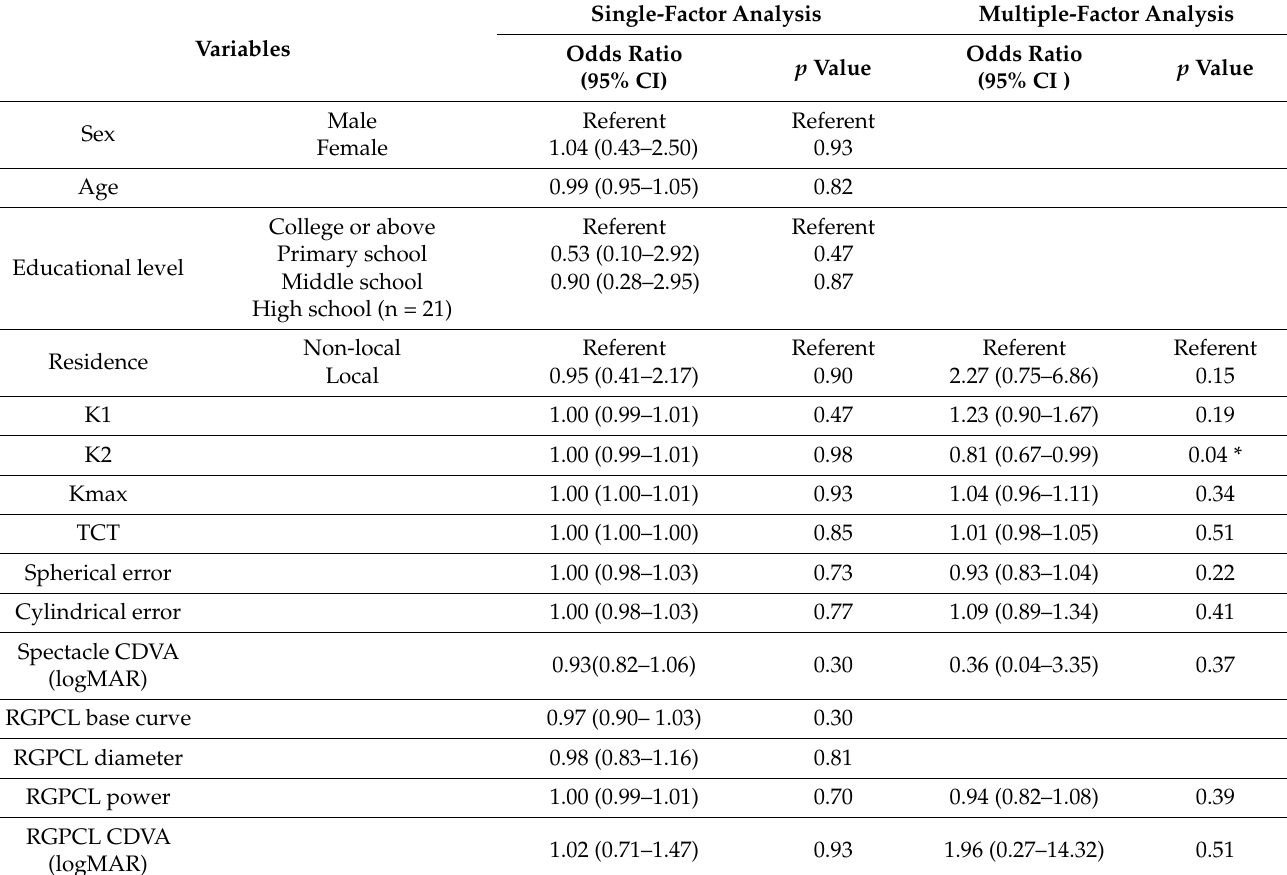
Table 5. Generalised estimating equation of the demographic and clinical data of the